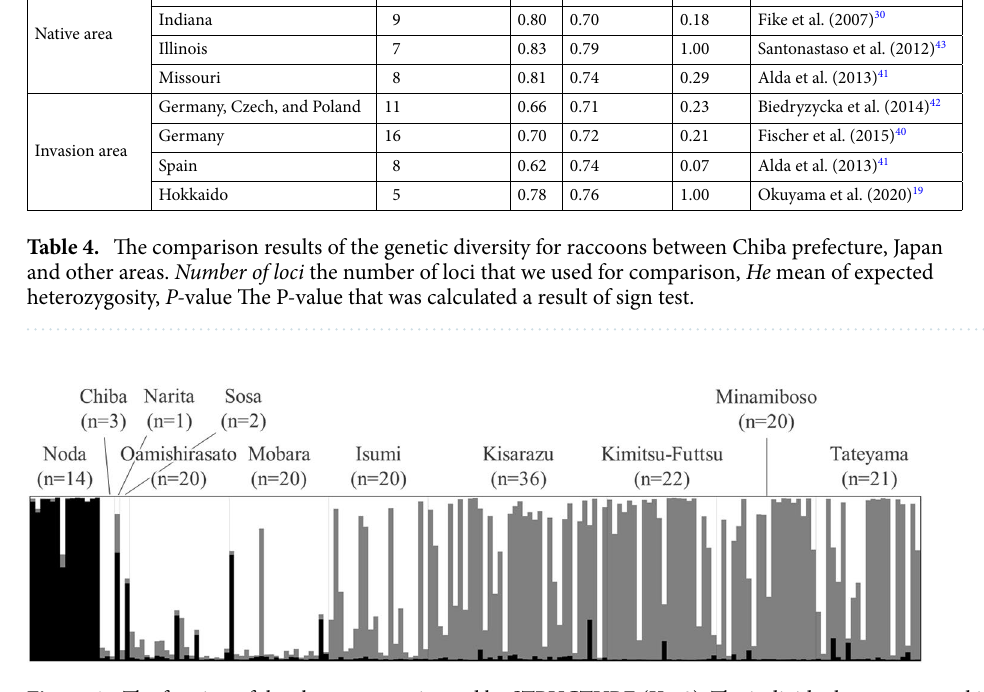
Area Number of loci He He of Chiba P- value Theses